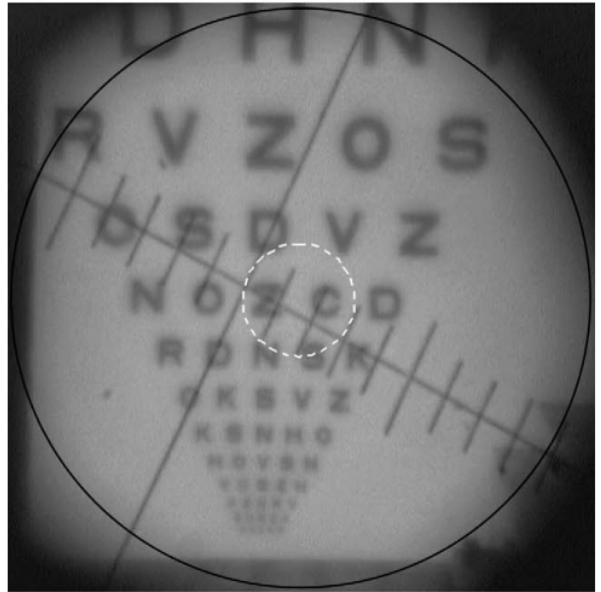
Figure 12. The imaging performance of the optomechanical eye model presented by Gobbi et al., showing the digitized electronic record of the retinal image corresponding to the projection of the ETDRS chart. Journal of Cataract & Refractive Surgery 2006, 32, 643–651 ([20]). Originally published by and reprinted with permission from Wolters Kluwer Health Inc.